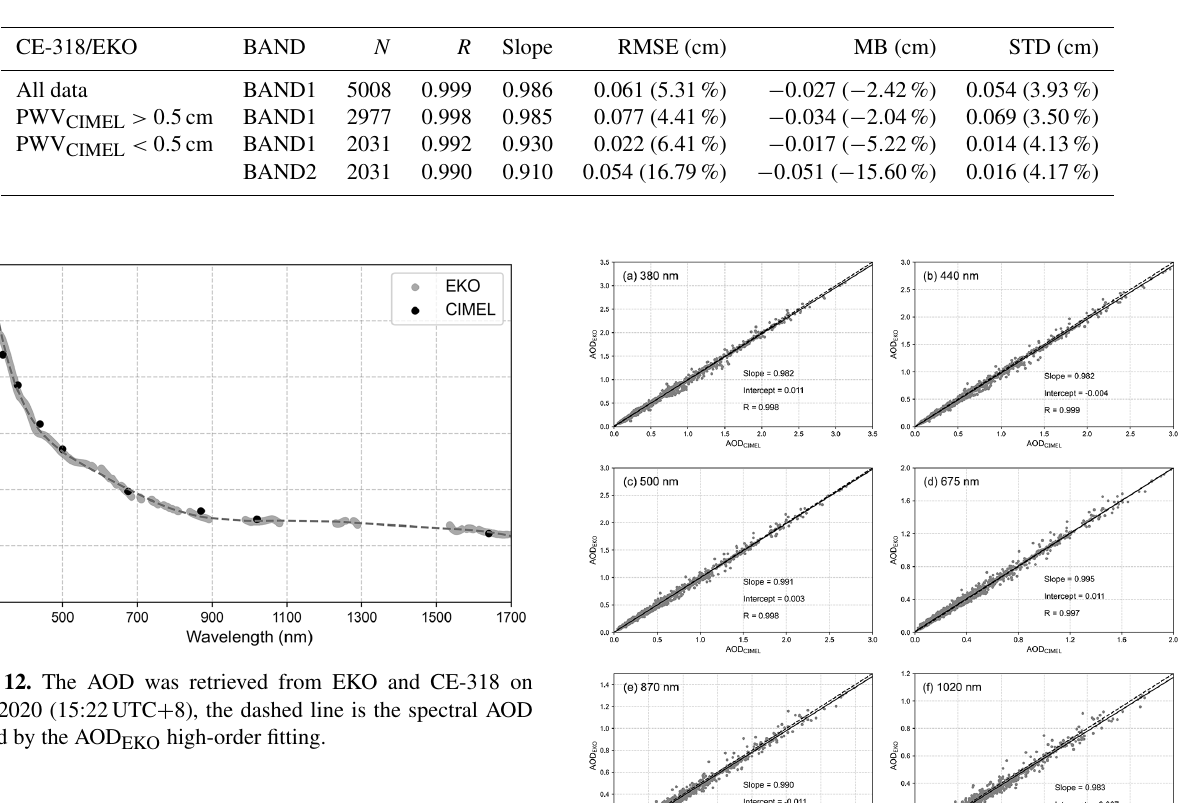
PWV and spectral AOD, and the results are compared with those from the collocated CE-318 sun